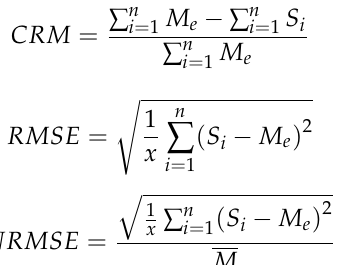
Table 1. Hydraulic parameters of L-soil and H-soil.